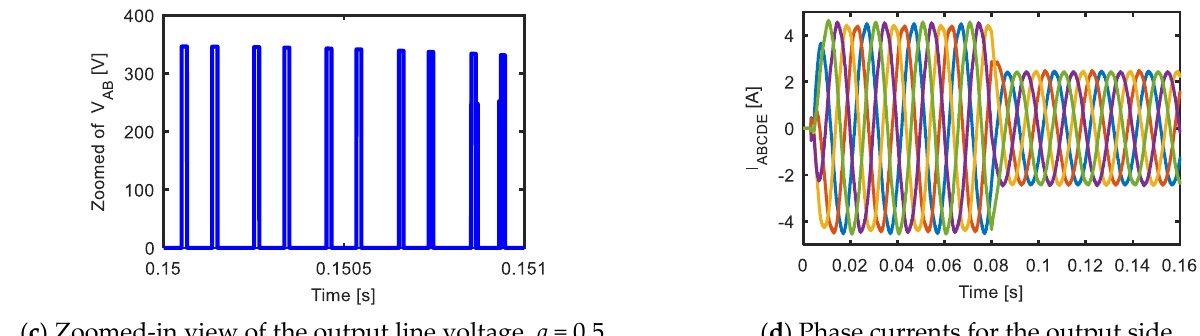
Figure 7. Simulation results for control of the magnitude of the output voltage and the 50 Hz output frequency.